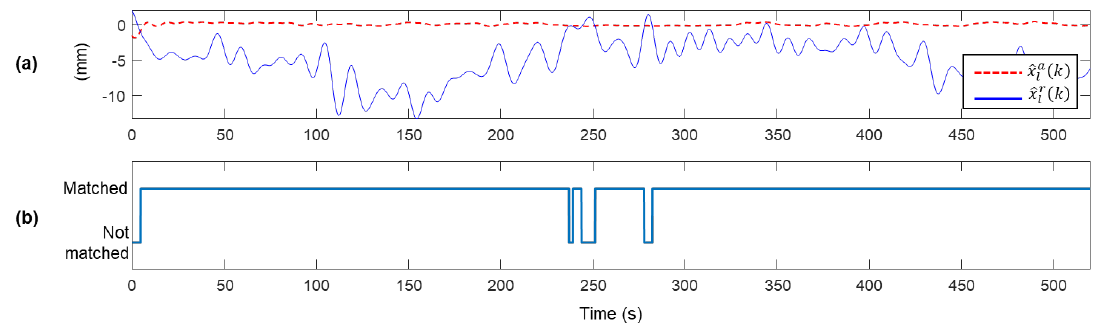
Figure 7. ( a ) Comparison of 𝑥̂ 𝑙𝒓 (𝑘) and 𝑥̂ 𝑙𝒂 (𝑘) and ( b ) a plot indicating whether the signs of 𝑥̂ 𝑙𝒓 (𝑘) − 𝑥̂ 𝑙𝒂 (𝑘) and 𝑥̂ 𝑙𝒓 (𝑘) − 𝑥 𝑙 (𝑘) match or not match. The two signs match in 96.63% of the time steps.